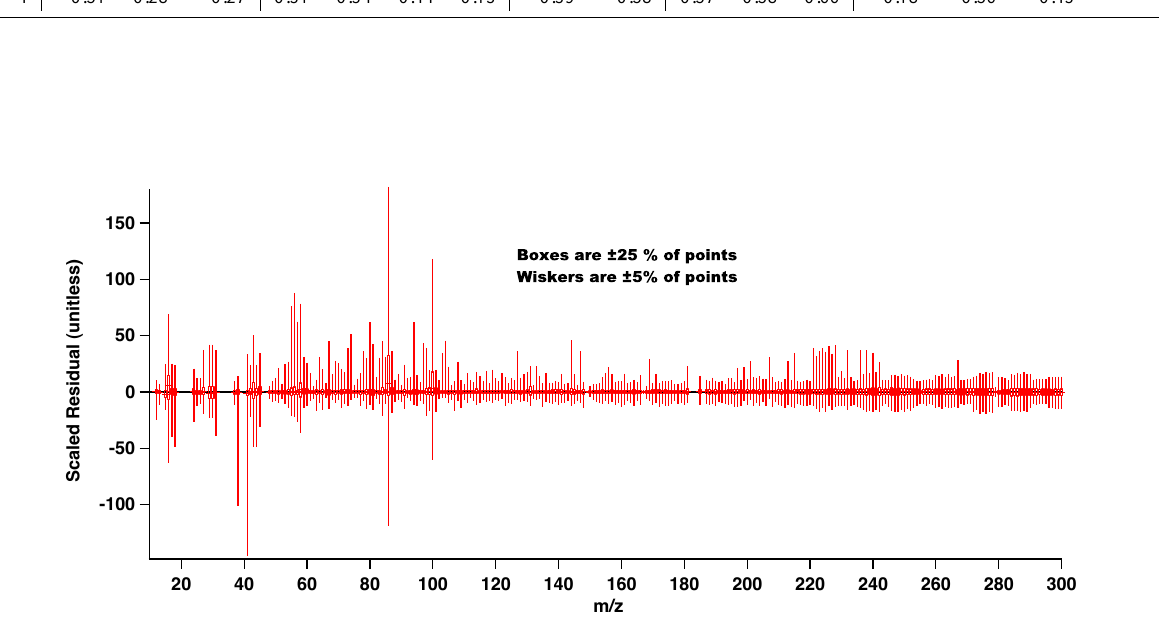
Fig. A4. Scaled residuals for the 3 factor solution (seed = 6).